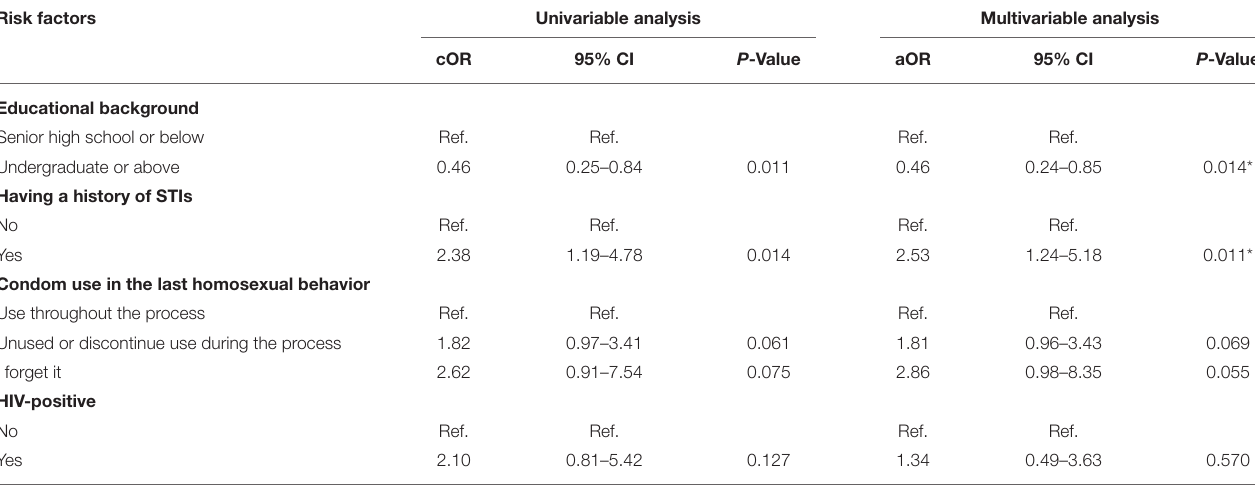
TABLE 3 | Ordinal logistic regression analysis for factors associated with acquiring more STIs among 177